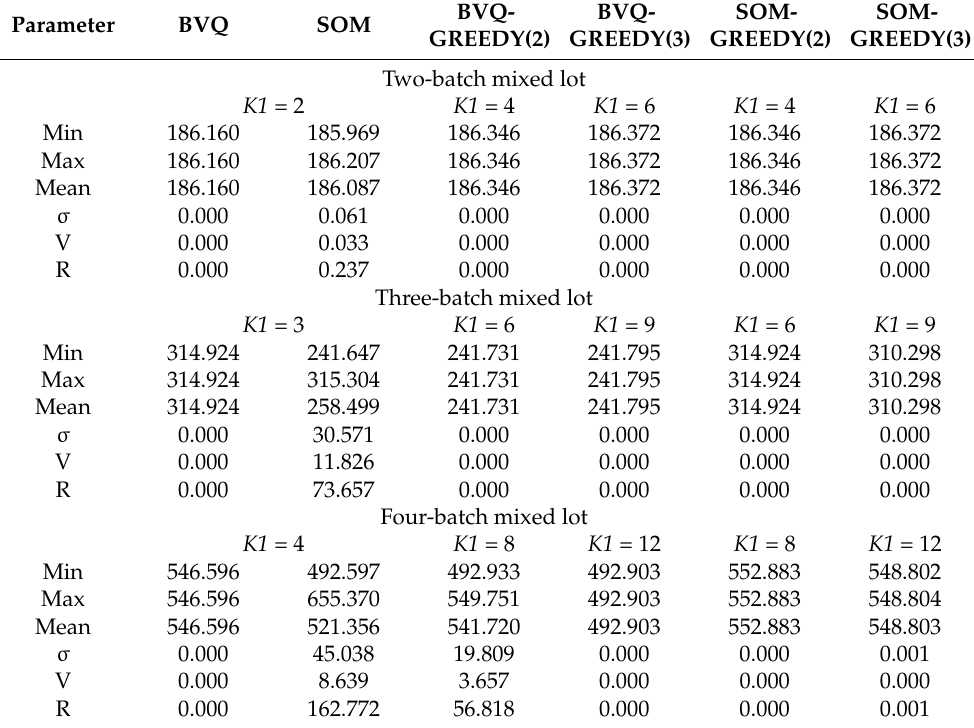
Table A4. Objective function value summarized after 30 attempts (Euclidean distance, initialization by